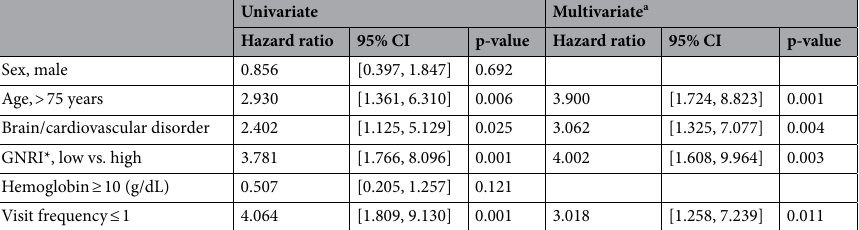
Table 2. Risk factors affecting patient survival after HD initiation. *The GNRI score was calculated using the following formula: GNRI = (14.89 × sAlb) + 41.7 × (BW/IBW). sAlb, serum albumin; BW, bodyweight; CI, confidence interval; GNRI, geriatric nutritional risk index; HD, hemodialysis; IBW, ideal body weight. a The multivariate Cox regression model initially included age, brain and cardiovascular disorder, GNRI score, and visit frequency.